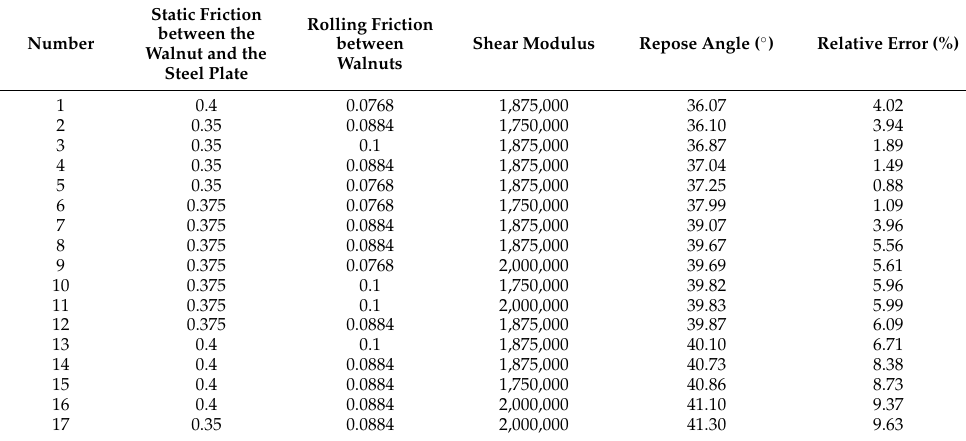
Table 7. The results of steepest ascent test.